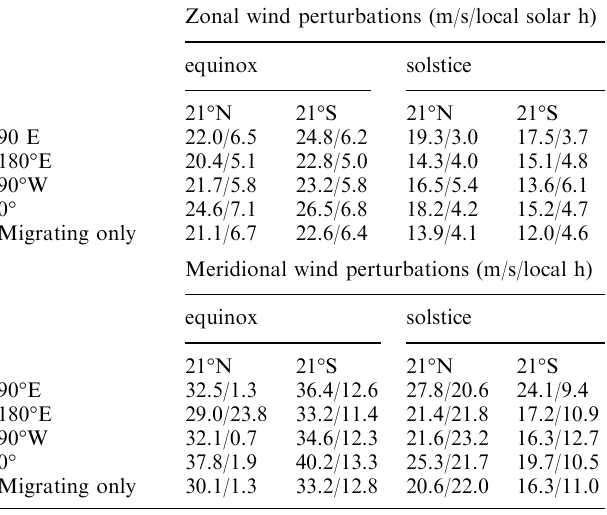
Fig. 4. Same as Fig. 3, except for January conditions Table 2. Nonmigrating signatures of the diurnal tide at 95 km modelled by GSWM Zonal wind perturbations (m/s/local solar